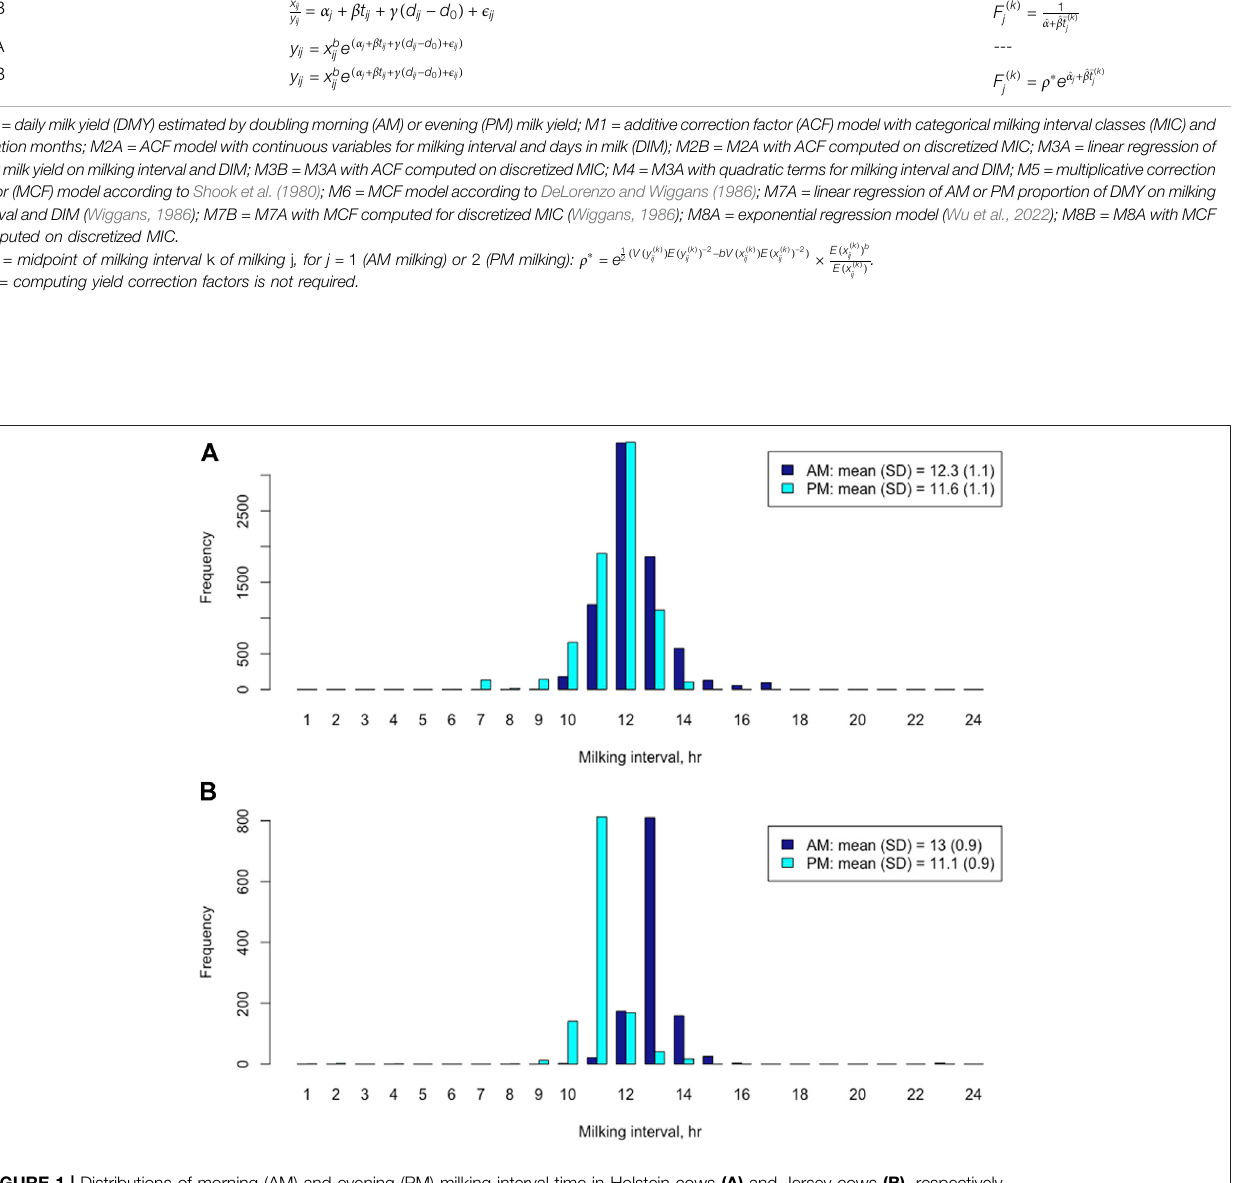
Frontiers in Genetics |